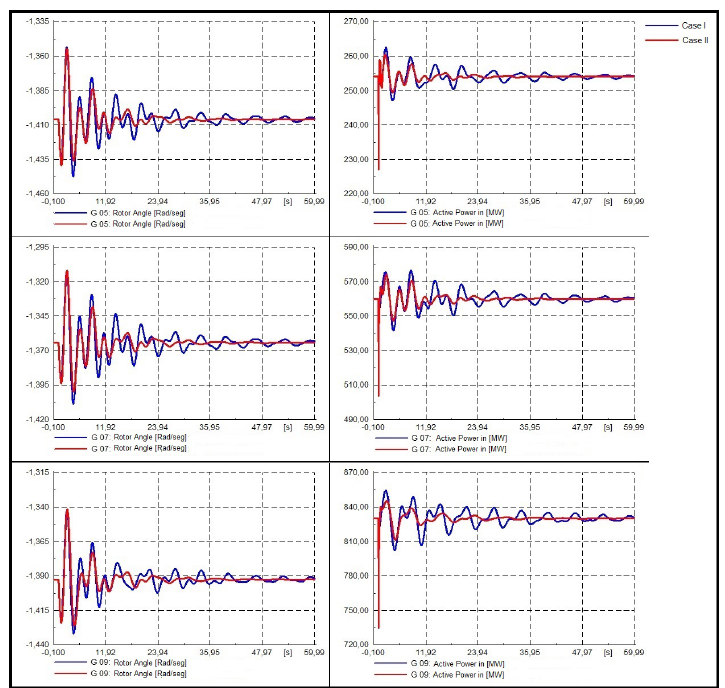
Figure 24. Rotor angle [rad] and Active Power [MW]-three phase fault at bus 39. It is possible to clearly visualize that for each system, the proposed tuning improves the non-linear system response, not only in the rotor angle but also in the active power of the synchronic machines to the three modeled contingencies considered in the present